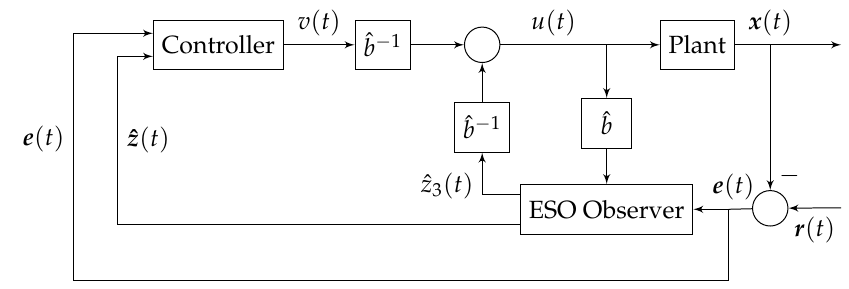
Figure 1. Error domain ADRC control